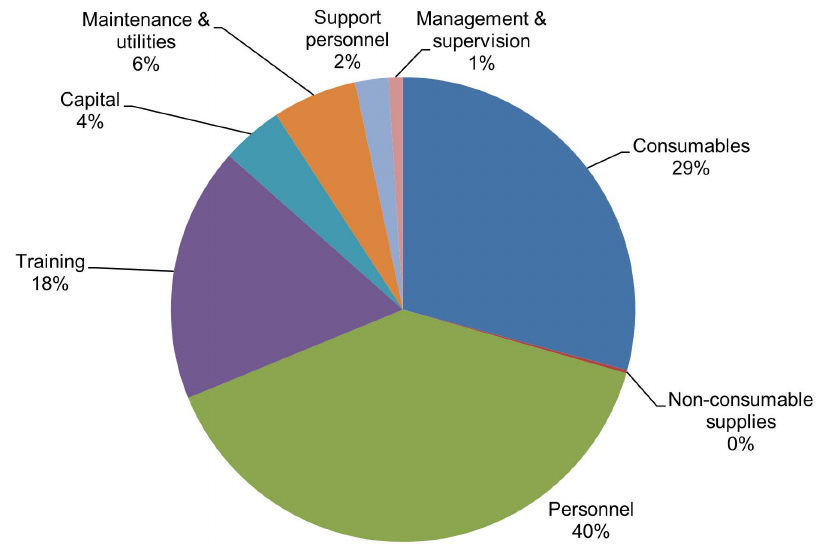
Figure 1. Cost drivers of VMMC in Tanzania, 2010–2011. doi:10.1371/journal.pone.0083925.g001 PLOS ONE |